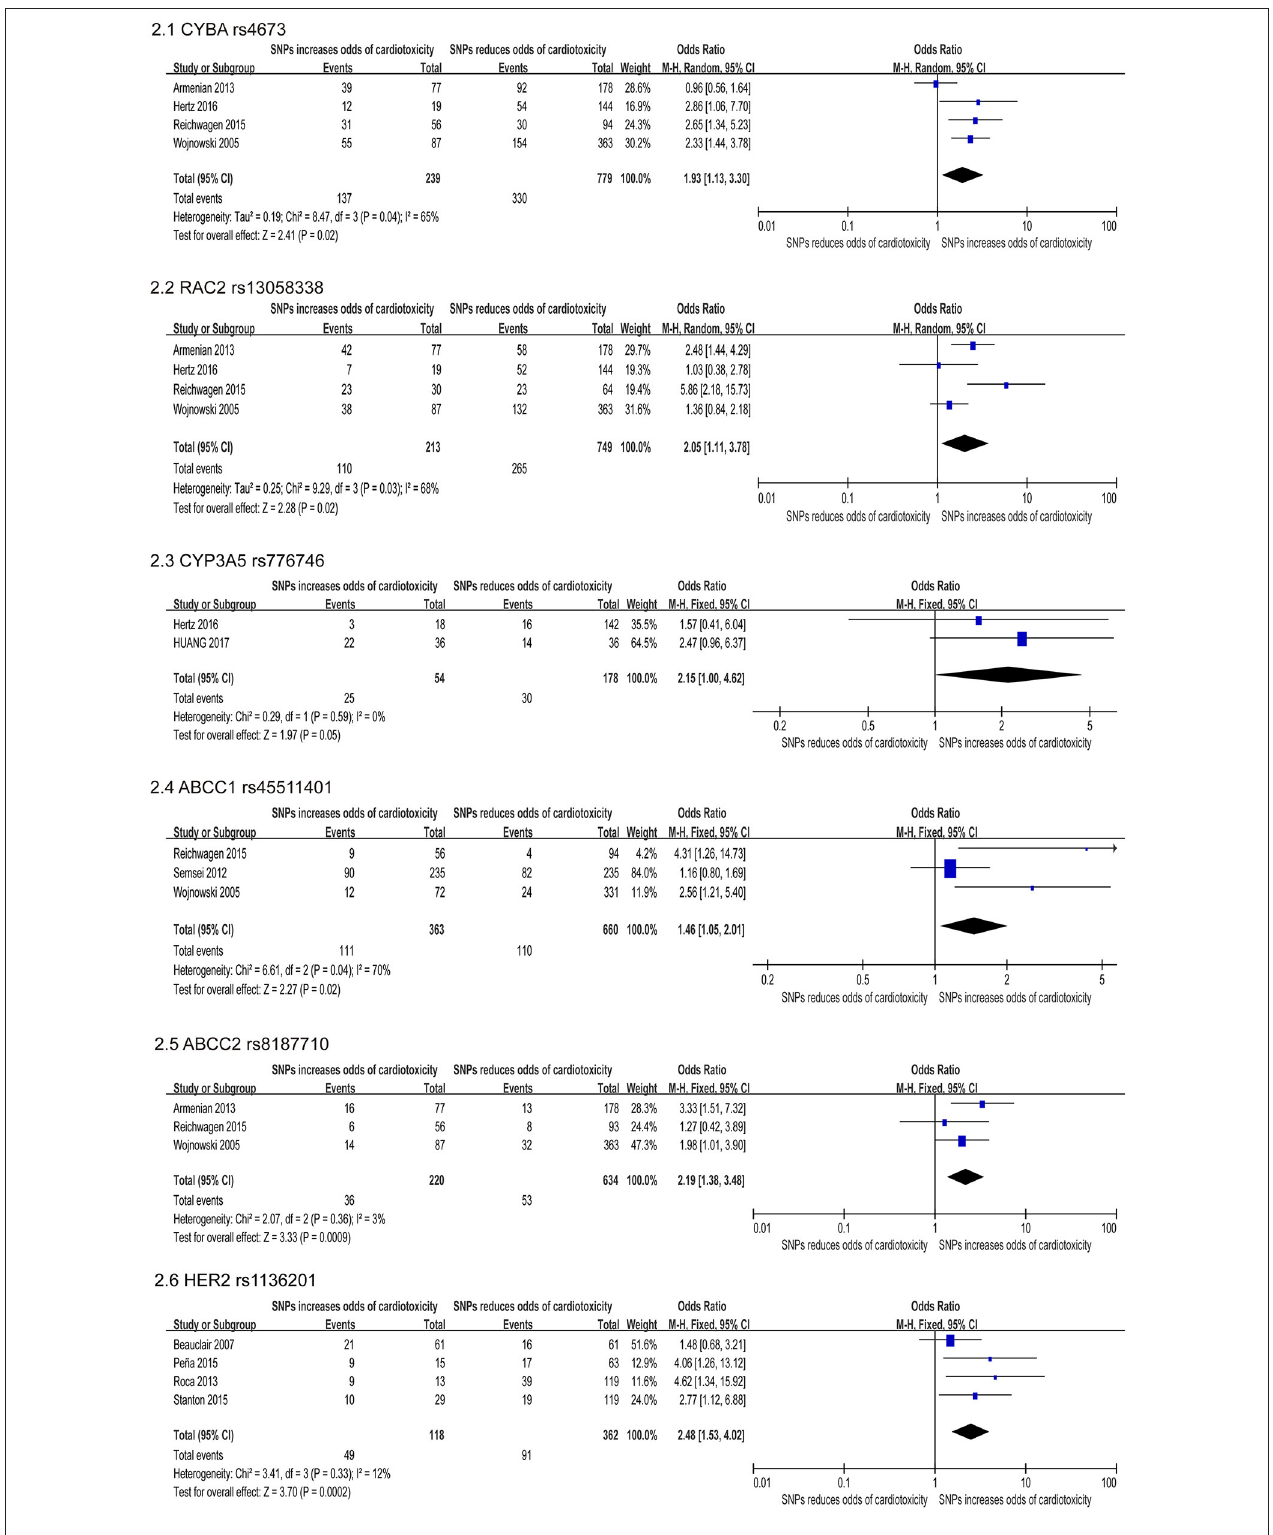
FIGURE 2 | Forest plot of meta-analysis for 6 SNPs. Six variants, CYBA rs4673, RAC2 rs13058338, CYP3A5 rs776746, ABCC1 rs45511401, ABCC2 rs8187710, and HER2 rs1136201 are significantly increased the odds for chemotherapy induced cardiotoxicity.